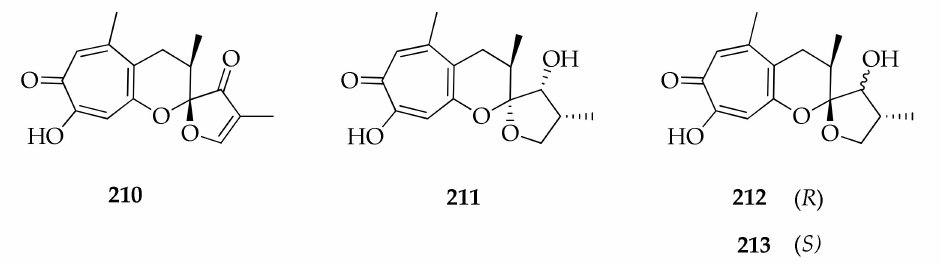
Figure 29. Structures of